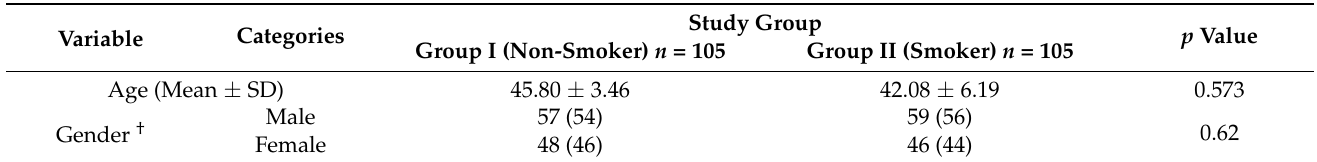
Table 1. Sample Characteristics.